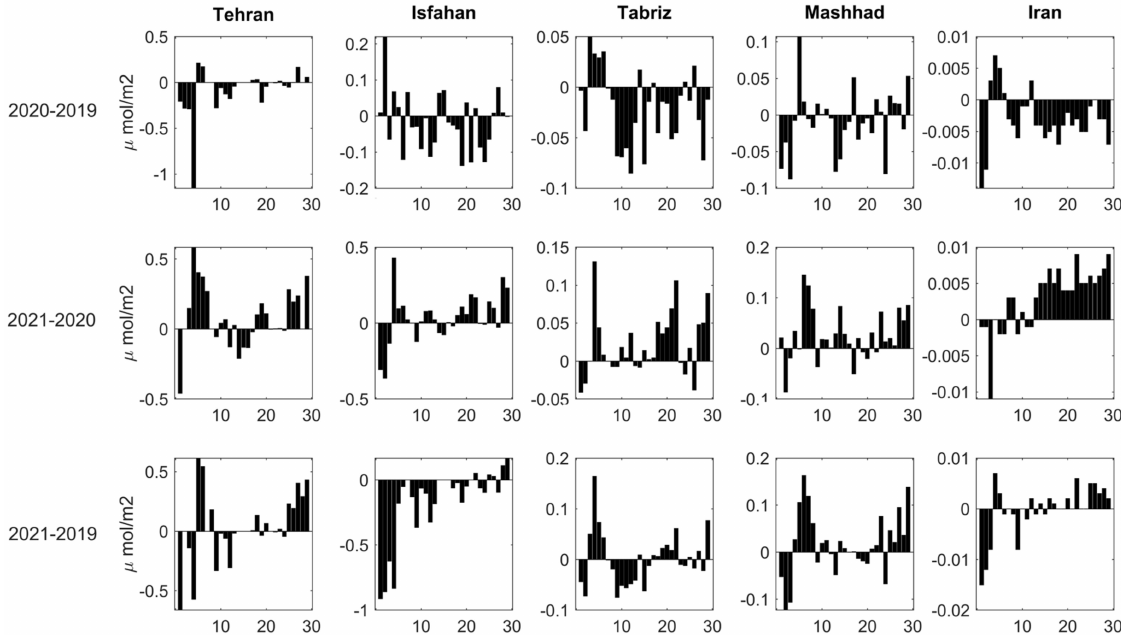
Figure 7. The difference charts of the daily NO 2 amount during March/April 2020–2019 ( first row ), 2021–2020 ( middle row ), and last row (2021–2019).